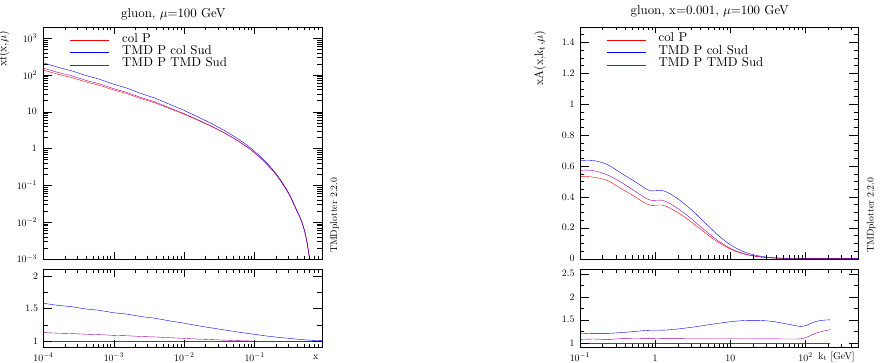
Figure 1: Collinear (left) and TMD (right) PDFs for gluons. The bottom plots show the ratio between the curves.